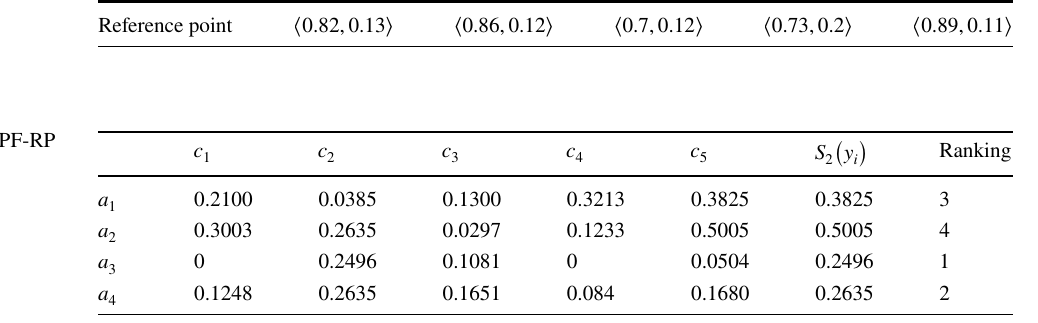
Table 10 Reference point